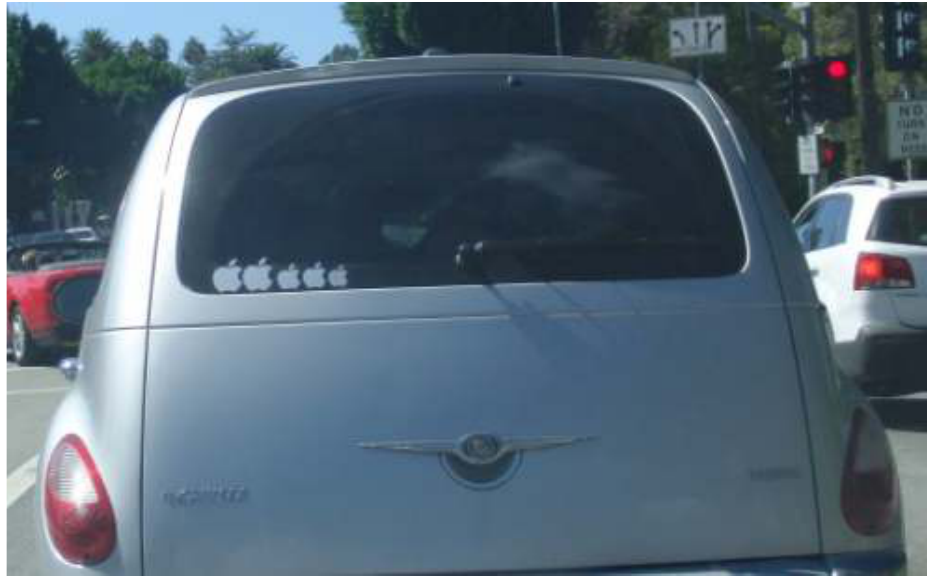
Source: Charles Joseph.